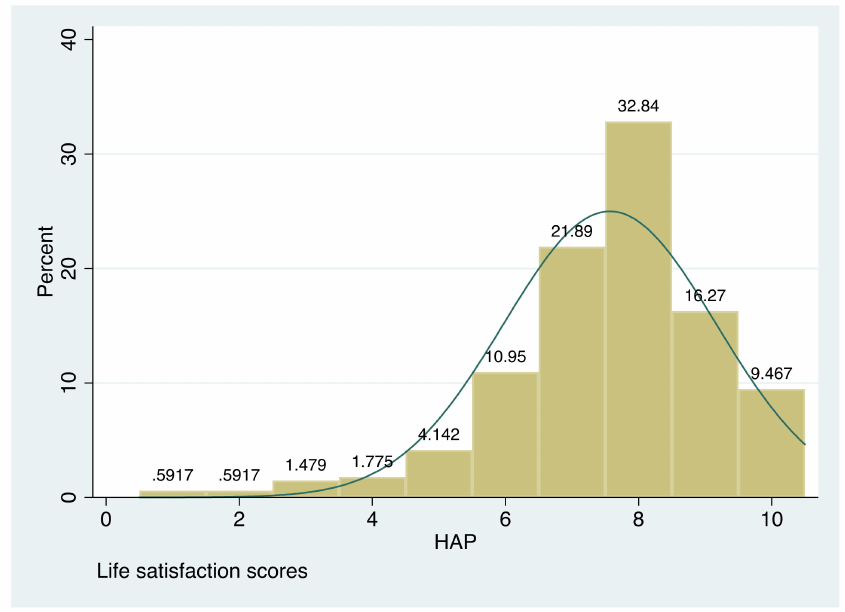
Figure 1. Life satisfaction